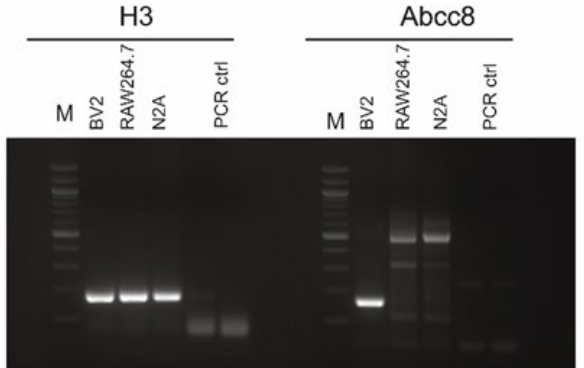
Figure 8. RT-PCR for H3 and Sur1/Abcc8. Five ng of cDNA were used in each PCR to amplify H3 (198 bps) and Abcc8 (166 bps) amplicons. Controls were obtained performing retro transcriptions on water, as well as including water in the PCR as an internal control. M: 100 bp ladder.